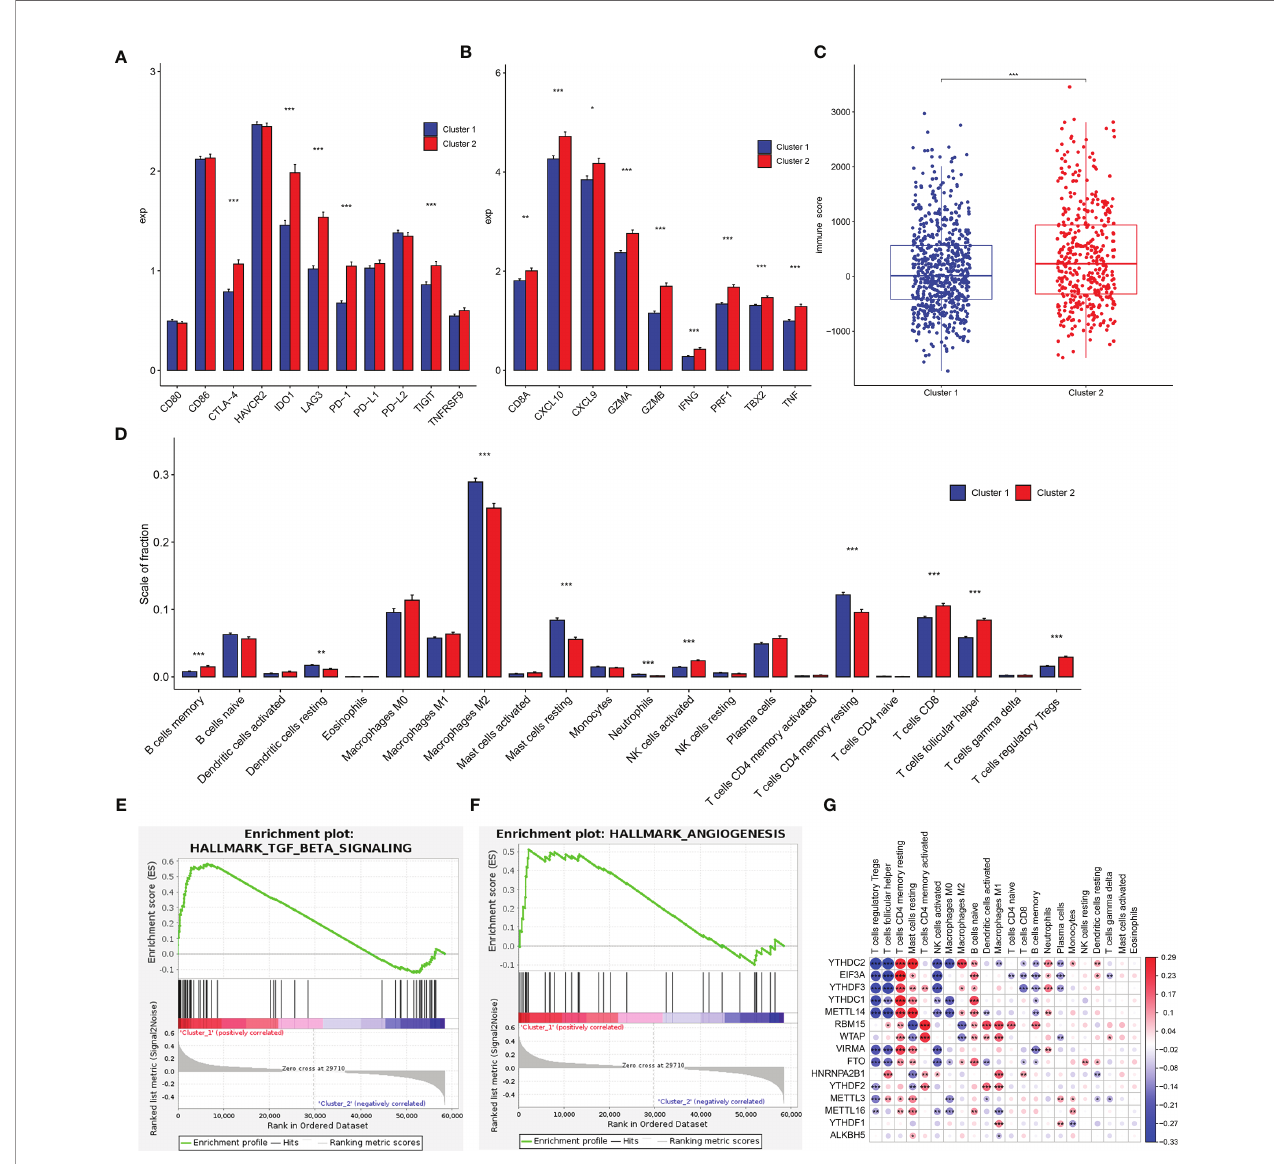
FIGURE 5 | Tumor immune microenvironment (TIME) cell in fi ltration characteristics and immune-related gene expression in two clusters. (A) Differential expression of immune checkpoint-related genes in two clusters. (B) Differential expression of immune activation-related genes in two subtypes. (C) Immunoscore in the cluster 1 and cluster 2 subtypes. (D) The in fi ltrating levels of 22 immune cell types in cluster 1 and cluster 2 from the TCGA cohort. (E, F) GSEA results revealed that TGF- b signaling (E) and angiogenesis (F) were signi fi cantly enriched in cluster 1. (G) The correlation between each TIME in fi ltration cell type and each m 6 A regulator using spearman analyses. Negative correlation was marked with blue and positive correlation with red. *p < 0.05, **p < 0.01, ***p <